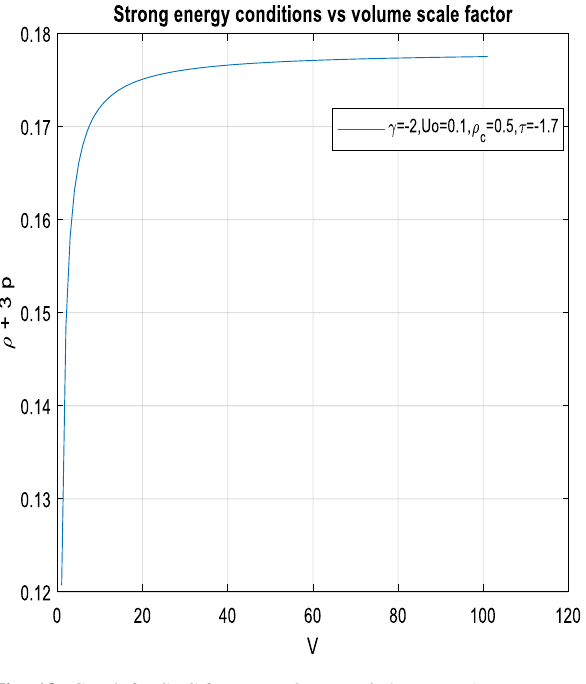
Fig. 18 Graph for SEC for γ = − 2 ; U 0 = 0 . 5 ; τ = − 1 . 7